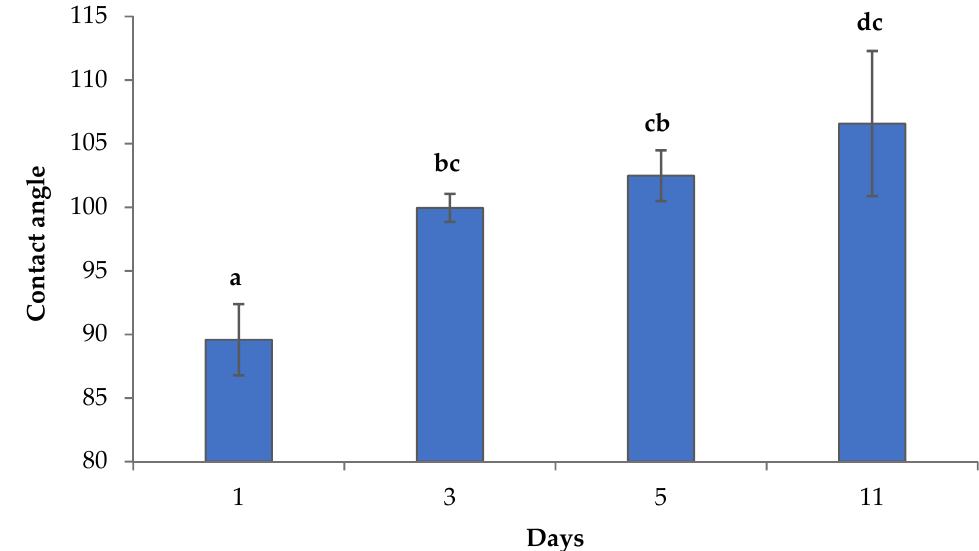
Figure 6. Contact angle ( θ ) of coated grapes at different storage times. Different Latin letters indicate significant differences among days ( T -test; p = 0.05).